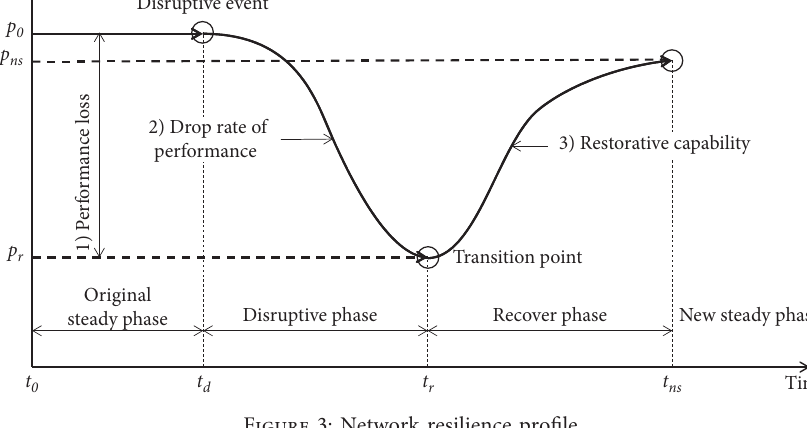
Figure 3: Network resilience profile.